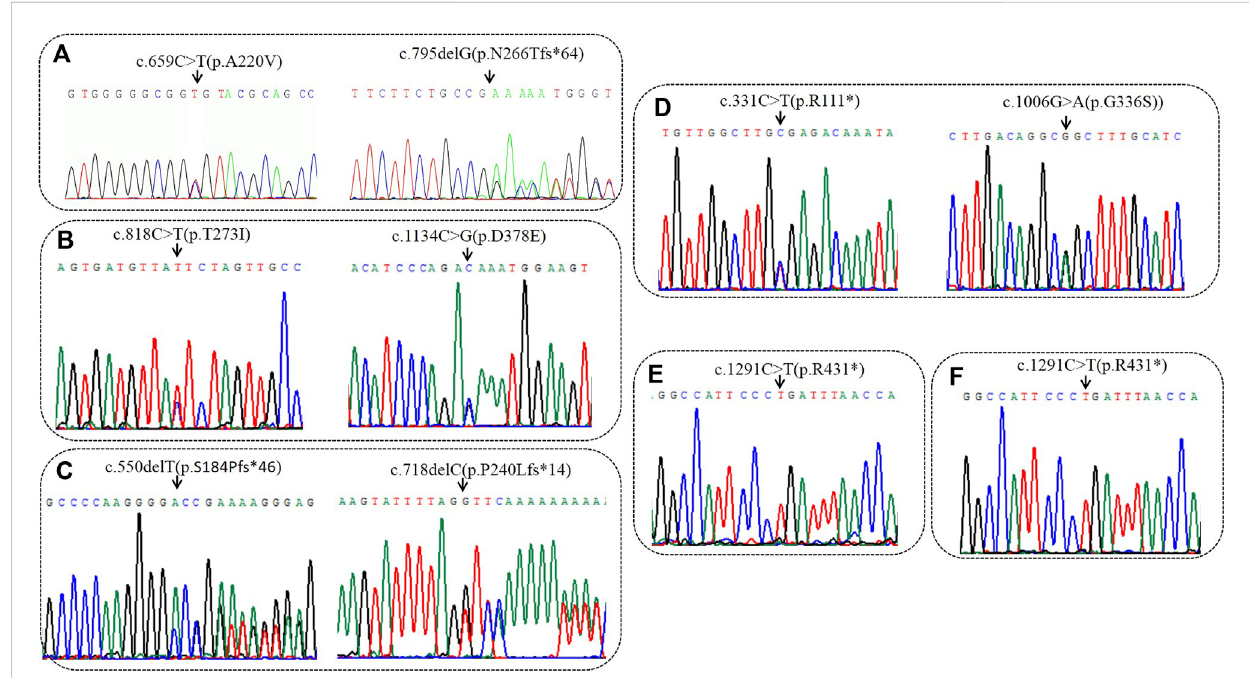
FIGURE 1 Sequencing analysis of all available members in six families with MSUD. (A) In family 1, sanger sequencing revealed the patient had the compound heterozygous variantis c659C > T(p.A220V) of paternal origin and c794delG (p.N266Tfs*64) of maternal origin in BCKDHA . (B) In family 2, sanger sequencing revealed the patient had the compound heterozygous variantis c1134C > G(p.D378E) of paternal origin and c818C > T(p.T273I) of maternal origin in BCKDHB . (C) In family 3, sanger sequencing revealed the patient had the compound heterozygous variantis c550delC (p.S184Pfs*46) of paternal origin and c718delC (p.P240Lfs*14) of maternal origin in BCKDHB . (D) In family 4, sanger sequencing revealed the patient had the compound heterozygous variantis c331C > T(p.R111*) of paternal origin and c1006G > A(p.G336S) of maternal origin in BCKDHB . (E) In family 5, the patient was